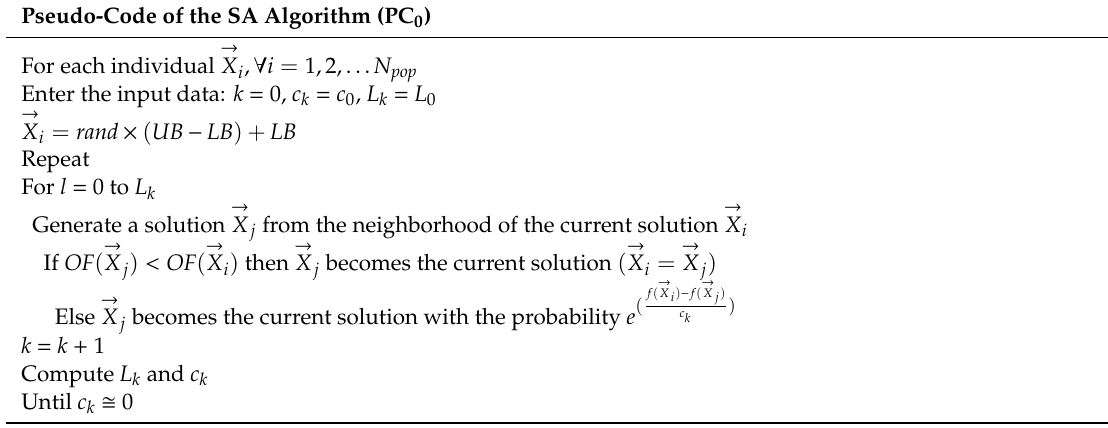
Table 1. Pseudo-code of the SA